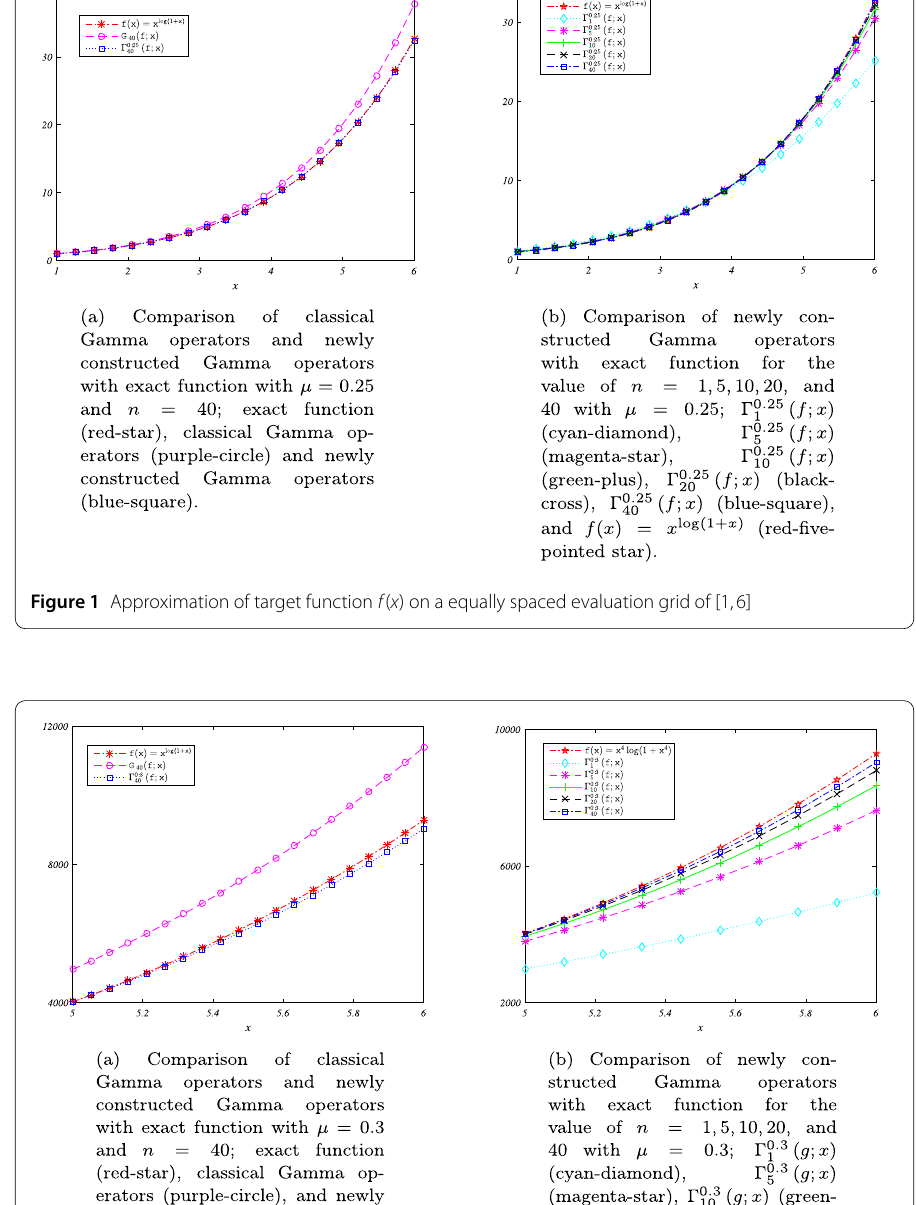
where β ( x , y ) is the Beta function. They studied some properties of the degenerate gamma and degenerate Laplace transformation and obtained their properties. The degenerate gamma and degenerate Laplace transformation can be included into engineer’s mathe- matical toolbox to solve linear ODEs and related initial value